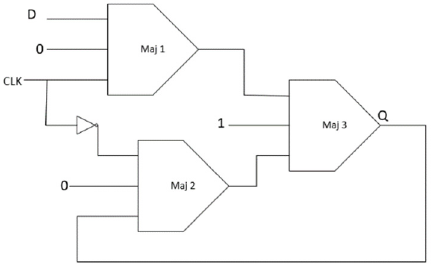
Figure 7. Logic diagram representation of DFF.